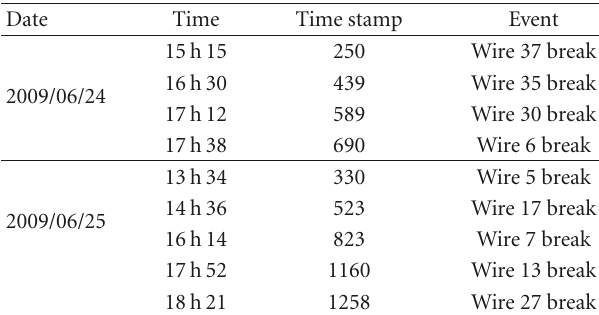
Table 7: Important